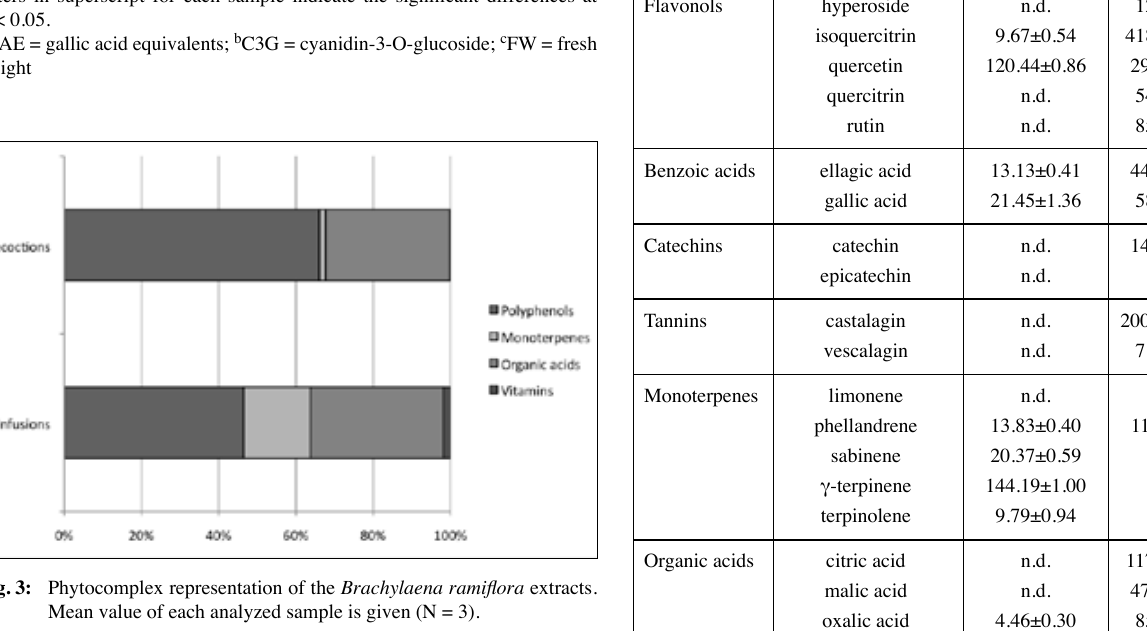
Fig. 3: Phytocomplex representation of the Brachylaena ramiflora extracts. Mean value of each analyzed sample is given (N = 3).